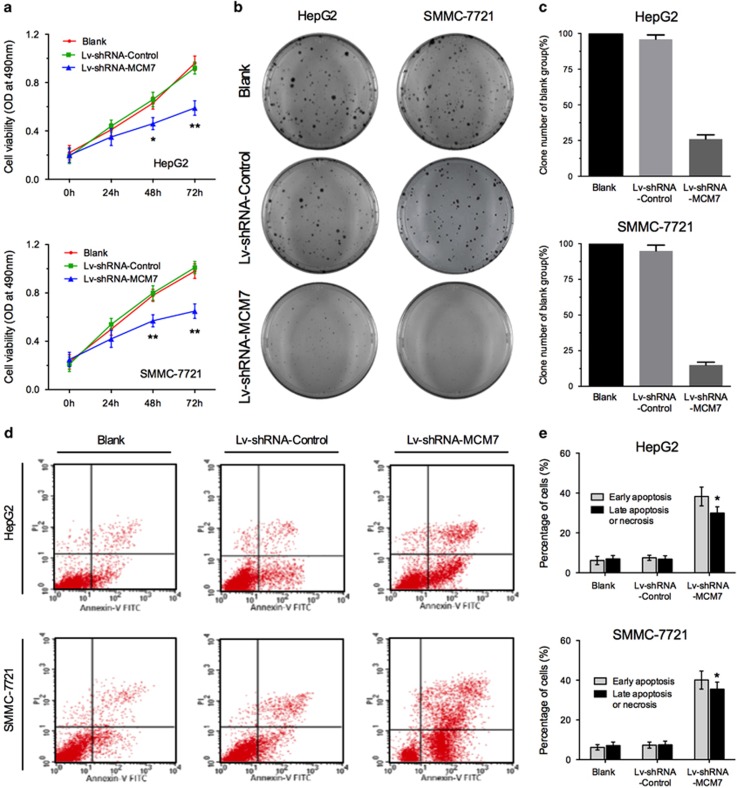
Knockdown of MCM7 inhibited proliferation of HCC cells. (a) MTT assay of HCC cells transfected by Lv-shRNA-MCM7 or Lv-shRNA-Control. (b and c) Colony-forming ability of HCC cells transfected by Lv-shRNA-MCM7 or Lv-shRNA-Control. (d and e) Flow cytometry analysis for apoptosis in HCC cells after 72 h of transduction. Data are represented as mean±S.E.M. from three independent experiments. *P<0.05; **P<0.01; ***P<0.001